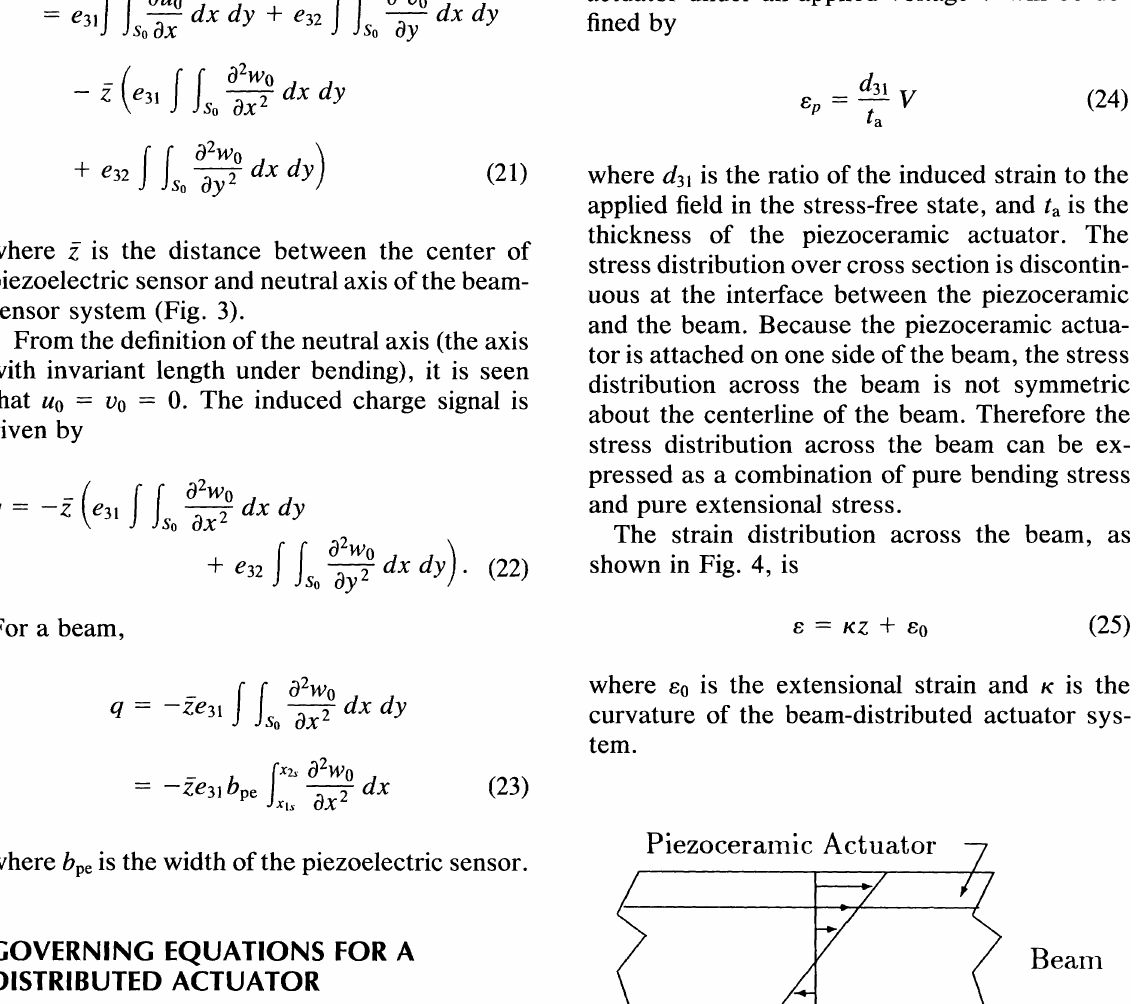
FIGURE 3 Coordinates in beam-distributed sensor system.